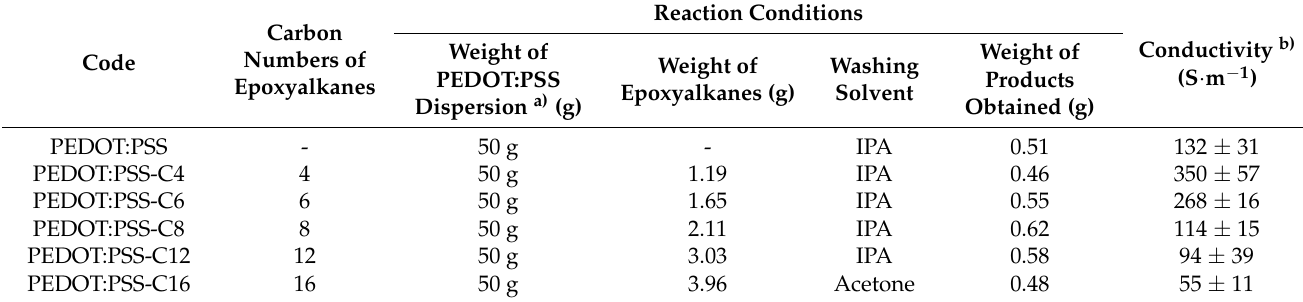
Table 1. Reaction conditions and conductivities of PEDOT:PSS